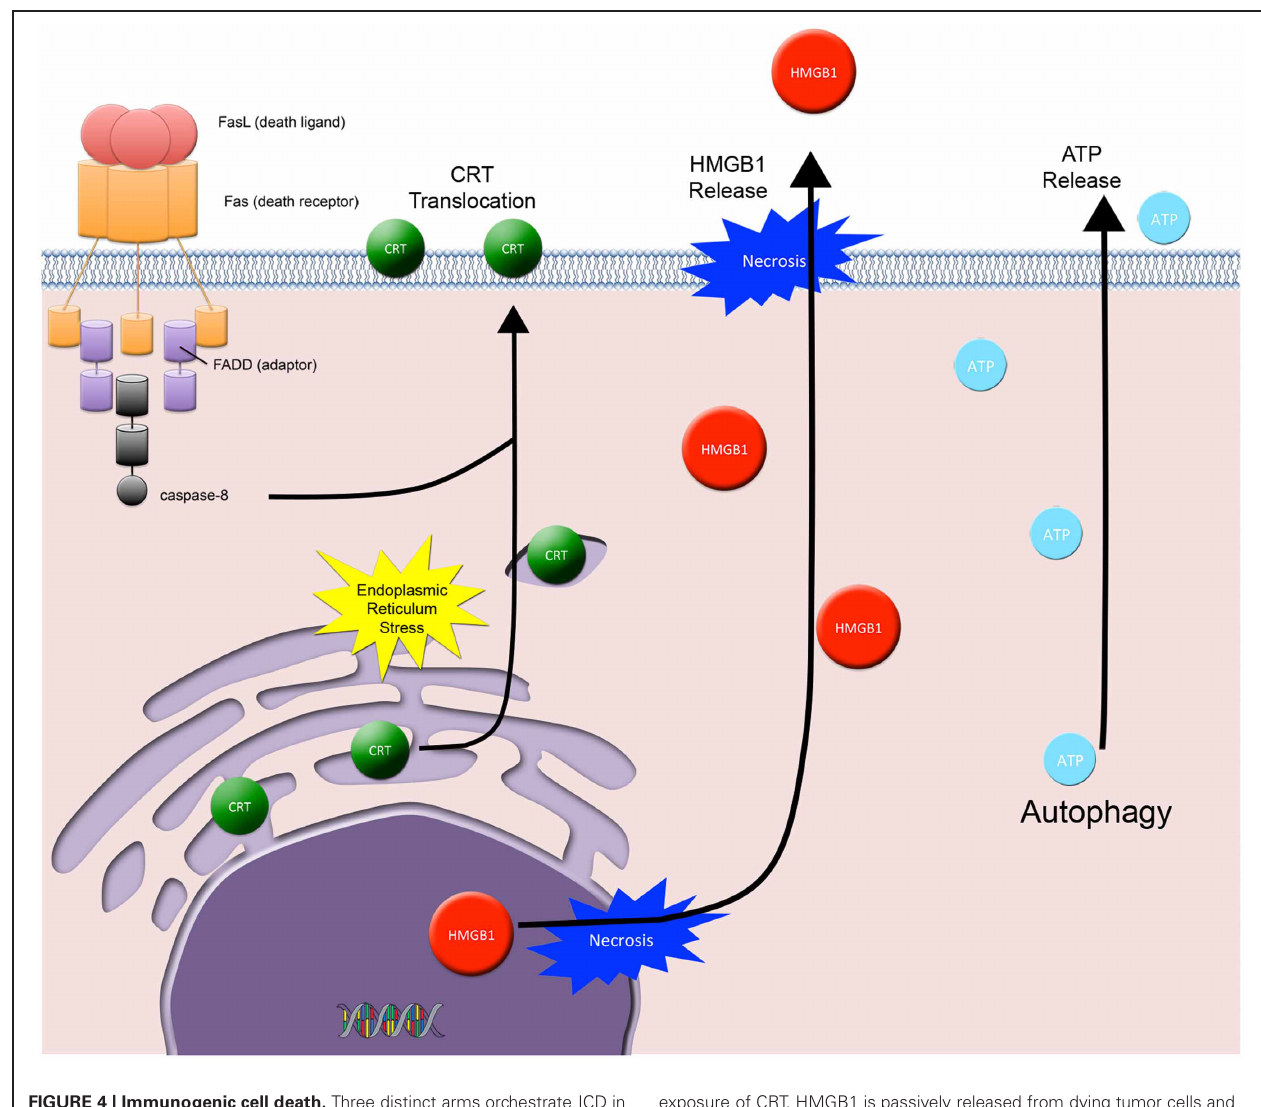
exposure of CRT. HMGB1 is passively released from dying tumor cells and acts as a cytokine and danger associated molecular pattern protein that mediates responses to infection, injury, and inflammation. ATP is released from dying tumor cells and involves the autophagic machinery. Extracellular ATP activates the dendritic cell (DC) P2X7 receptor, which is involved in the upregulation and activation of the DC